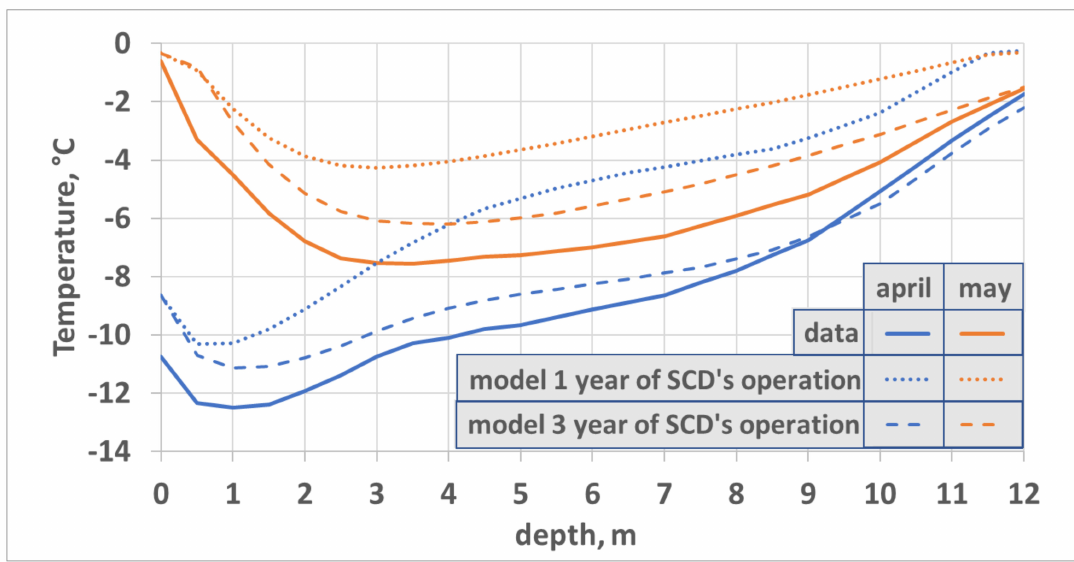
Figure 18. Temperature profiles in SAM well 44–1 in April–May 2021 obtained from temperatures measured using temperature sensors (continuous lines), numerical calculations which used 1 year of operation of SCDs (dot lines) and 3 years of operation of SCDs (dash